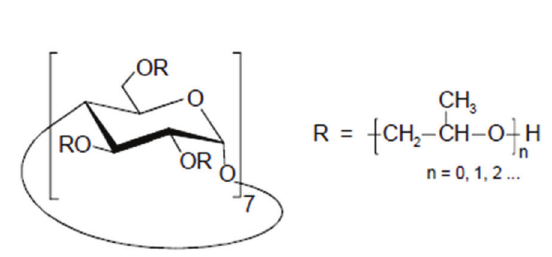
FIGURE 1 - The chemical structure of 2-hydroxypropyl-β- cyclodextrin.